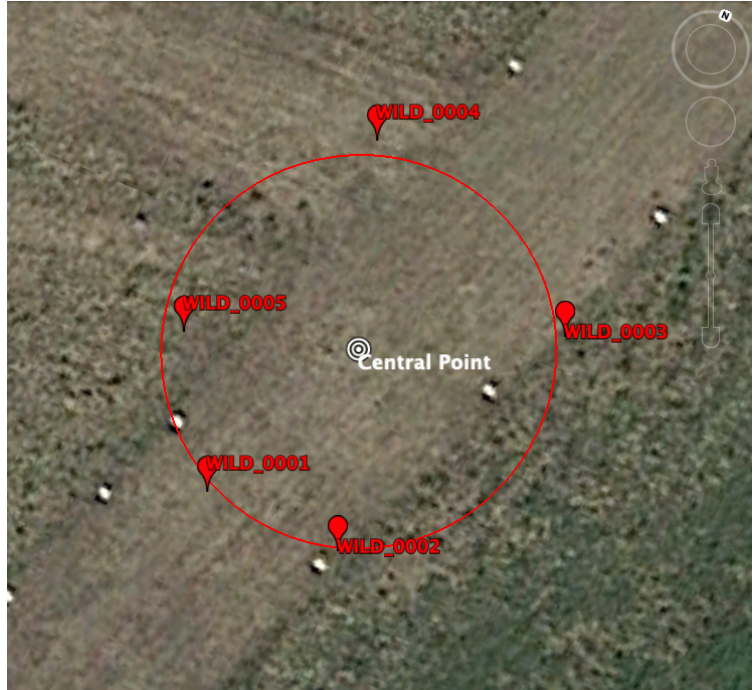
Figure 1. The five WiFi routers were placed around a circle of 10 m, centered at the Central Point (CP). The positions of the routers and CP where surveyed using a Septentrio AsteRx GNSS receiver and a Post Processing Kinematic (PPK)